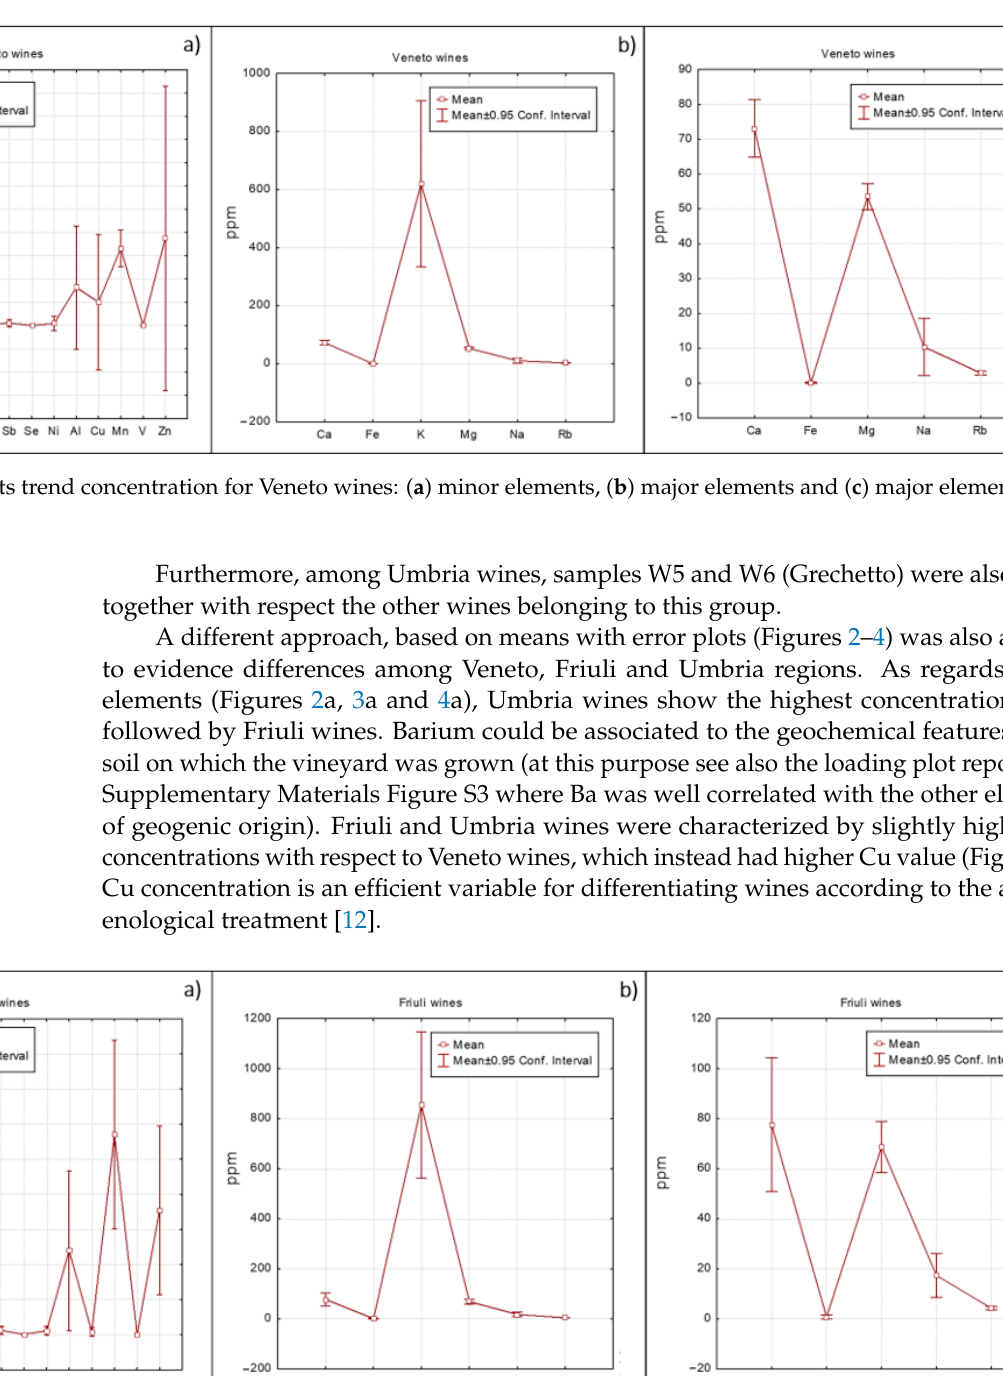
8 of 19 Figure 1. Scatter plot (for PC1, PC2 and PC3) obtained from PCA carried out on the element concentrations excluding